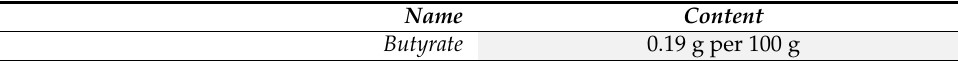
Table 1. GC/MS of Fermented